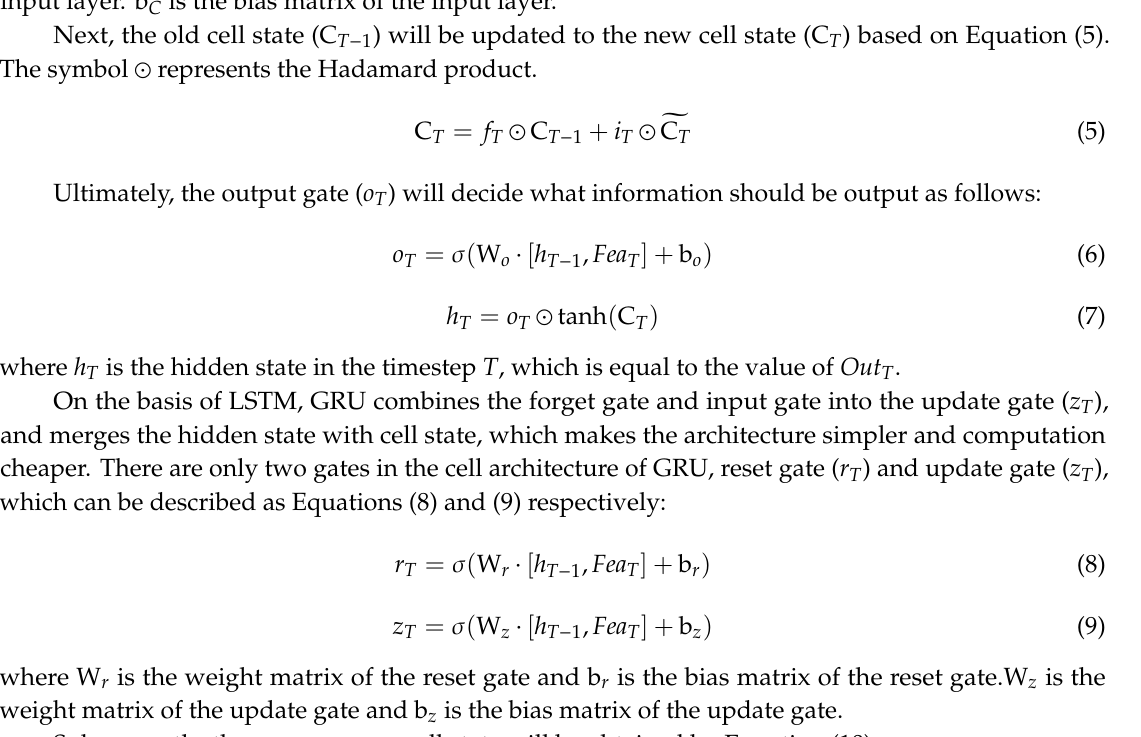
Figure 7. Diagram of three popular activation function: ( a ) sigmoid; ( b ) tanh; ( c ) ReLU.